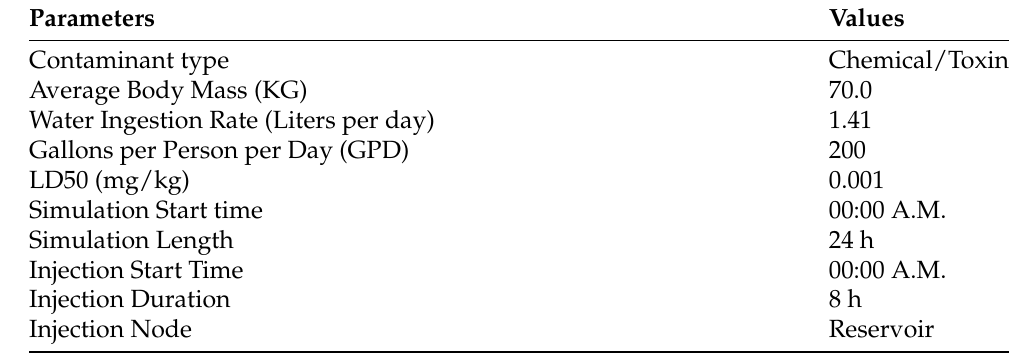
Figure 3. The concentration of the contaminant after 8 h for the injected node (reservoir). Table 1. Water contaminant